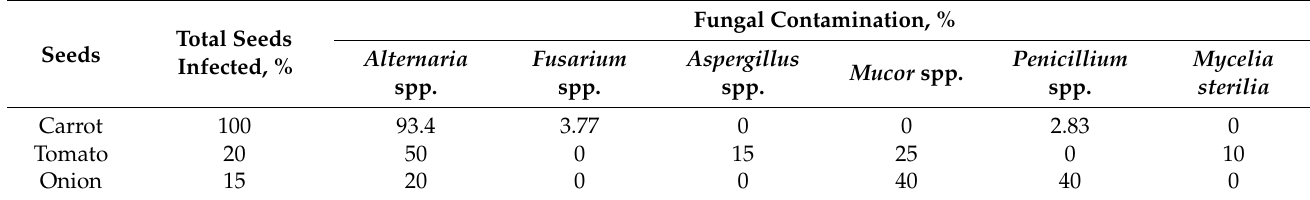
Table 2. Seeds contamination with fungi after seven days of